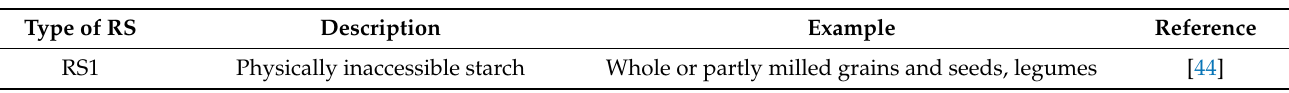
Table 1. Classification of types of resistant starch (RS), food sources, and factors affecting their resistance to digestion in the colon [42,43]. Type of